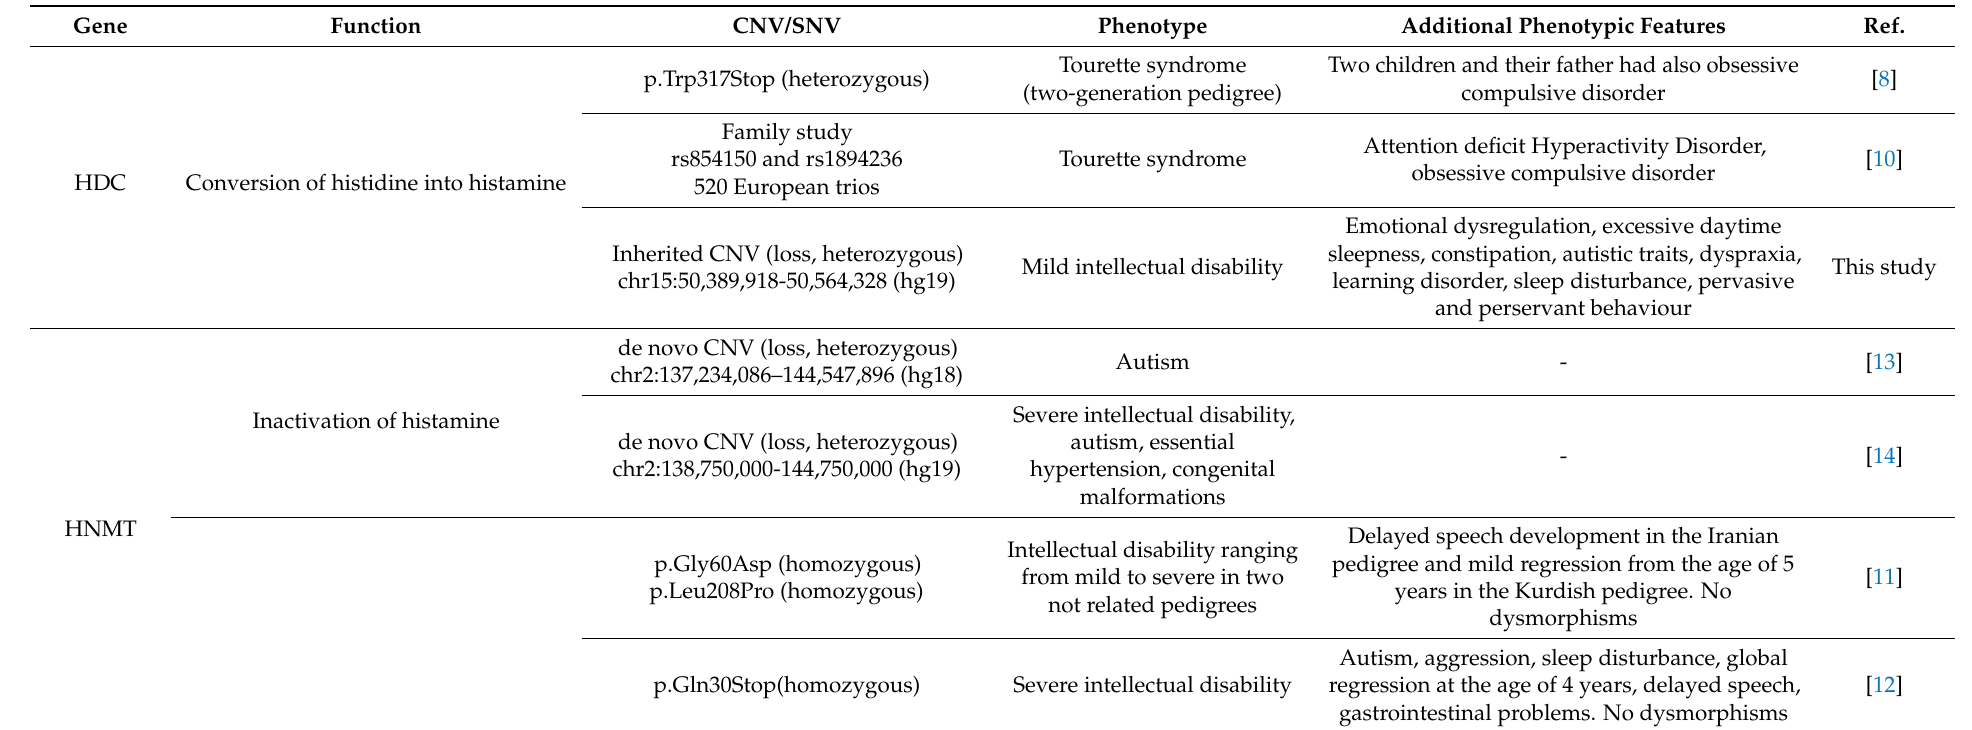
Table 2. Genotype–phenotype correlations relative to variants found in HDC and HNMT